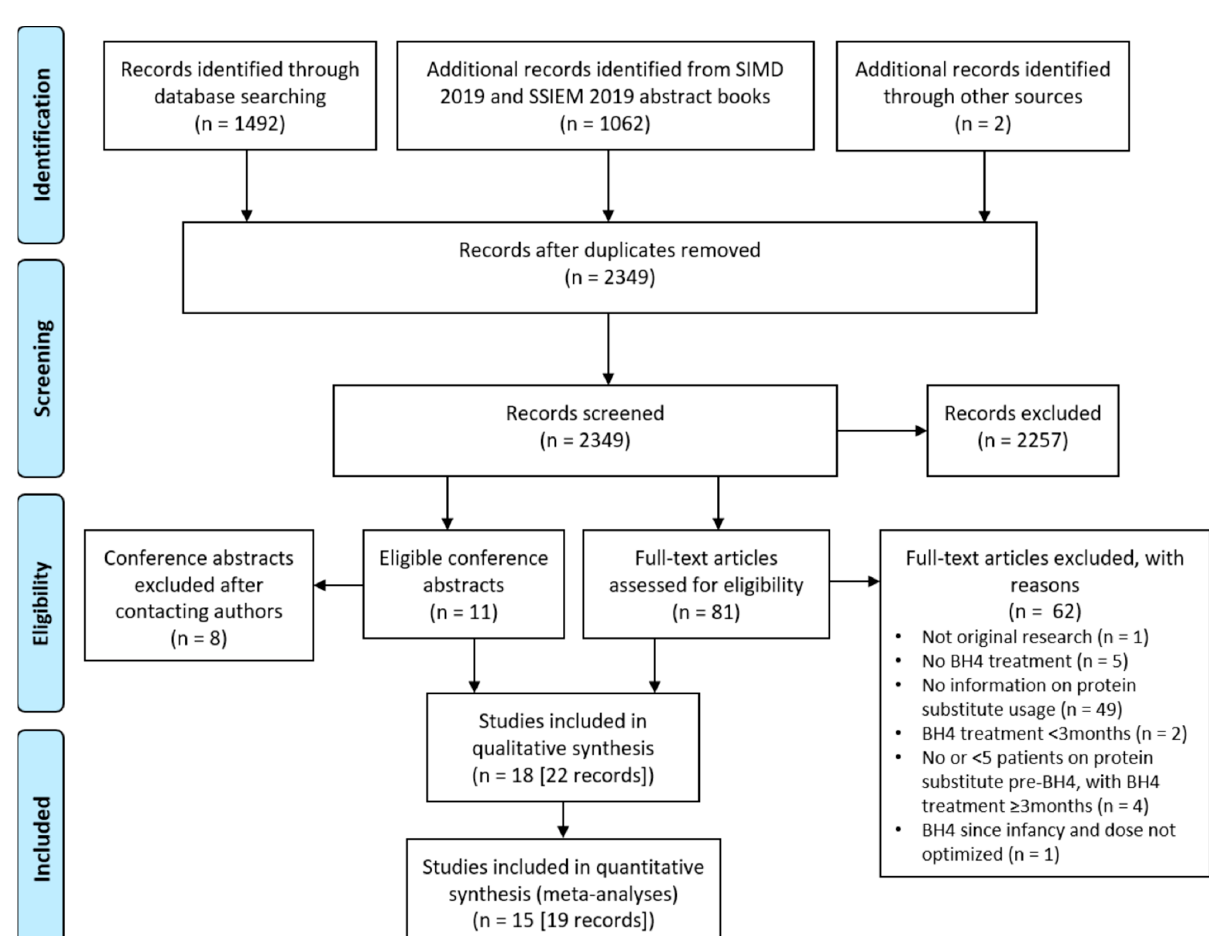
Figure 1. Study selection process according to the Preferred Reporting Items for Systematic Reviews and Meta-Analysis (PRISMA) flow chart.